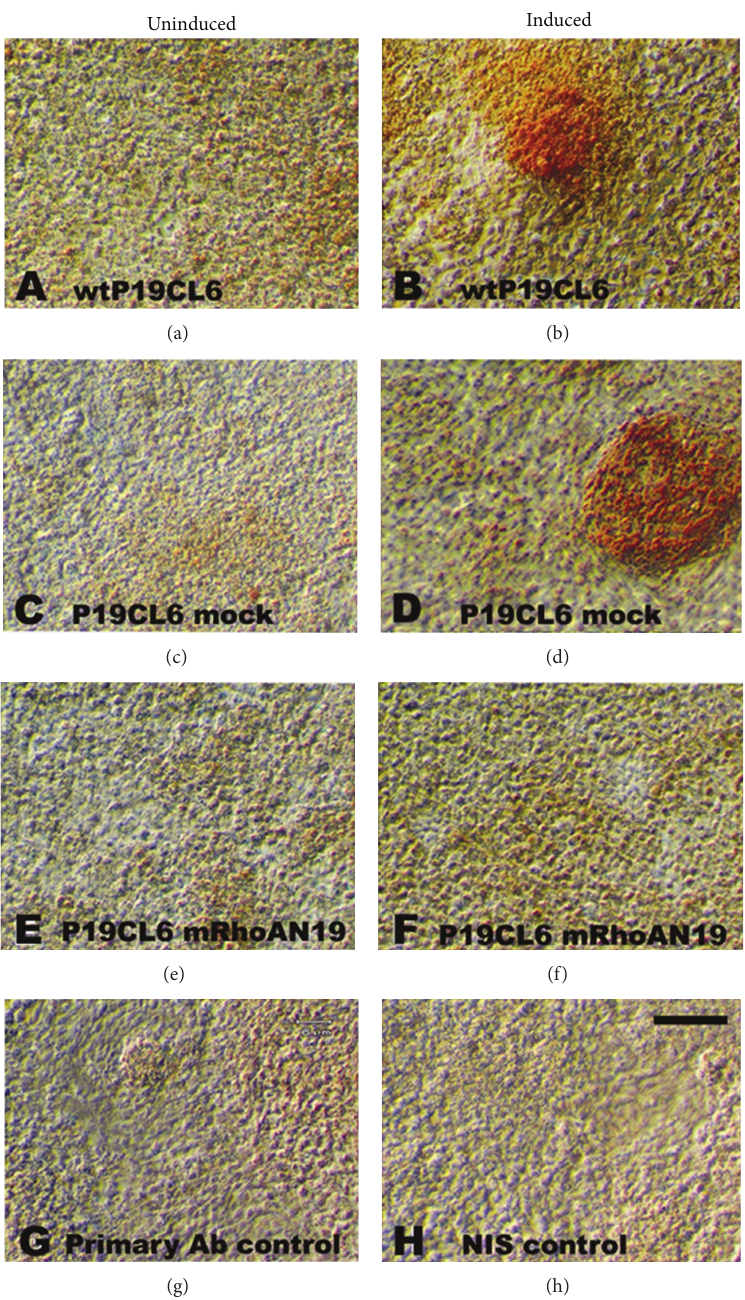
Figure 4: A dominant negative form of RhoA blocks differentiation of P19CL6 cells into a cardiomyocyte-like phenotype. P19CL6-derived cell lines weregrown ingrowth medium ordifferentiation medium (growth medium containing 1% DMSO)in 24-well culturedishes fromday of seeding and induction (D 0 ) for 16 days (D 16 ). Differentiated cardiomyocyte clusters (D 16 ) were detected using a cardiac troponin-I (cTnI) antibody. (a)–(f) P19CL6 cell lines processed with cTnI antibody: wt P19CL6, wild-type (nontransfected) P19CL6 cells; P19CL6 mock, P19CL6 cells stably transfected with expression plasmid alone; P19CL6mRhoAN19, P19CL6 cells stably transfected with plasmid expressing dominant negative mouse RhoAN19; (g) primary antibody (Ab) control (i.e., lacking primary antibody); (h) nonimmune mouse serum (NIS) control. Addition of 1% DMSO resulted in differentiation into a cardiomyocyte-like phenotype in P19CL6 cells and the mock transfected P19CL6 cell lines but not in the dominant negative mutant (P19CL6mRhoAN19) cells. (b), (d) Beating clusters, once processed for cTnI immunodetection displayed cTnI-positive cell clusters (red/brown staining). Bar = 10 𝜇